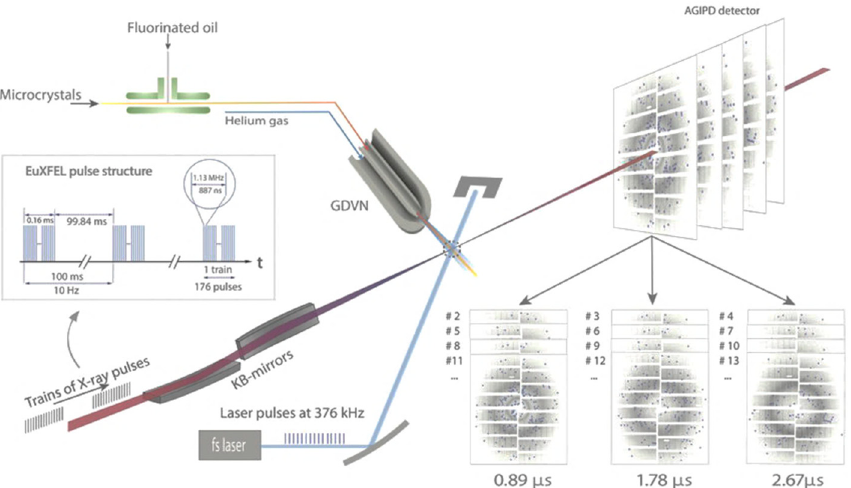
Figure 2. Pump–probe MHz TR-SFX setup using the SPB/SFX instrument of the European XFEL. This setup was implemented during the very first pump–probe TR-SFX experiments [18]. In this setup, X-ray pulses arrive in 1.13 MHz bursts with each burst contains 176 X-ray pulses, which repeat every 100 ms. The fs-pump laser delivers 376 kHz pulses in the blue ( λ = 420 nm), tunable based on the sample requirements, synchronized to the X-ray pulses which intersect precisely with the microcrystal jet produced by the GDVN. The pump–probe experimental scheme was designed as follows: one light triggered a ( ∆ t = 0.89 µs) pattern followed by two dark patterns (no light triggering: ( ∆ t = 1.78 and 2.67 µs)) to prevent light contamination from the previous laser excitation. The time delay between each pattern equaled 887 ns, corresponding to the X-ray pulse spacing at 1.13 MHz with each pattern representing a different probed crystal. The TR-SFX diffraction patterns were collected on an AGIPD detector (adapted from [18]).